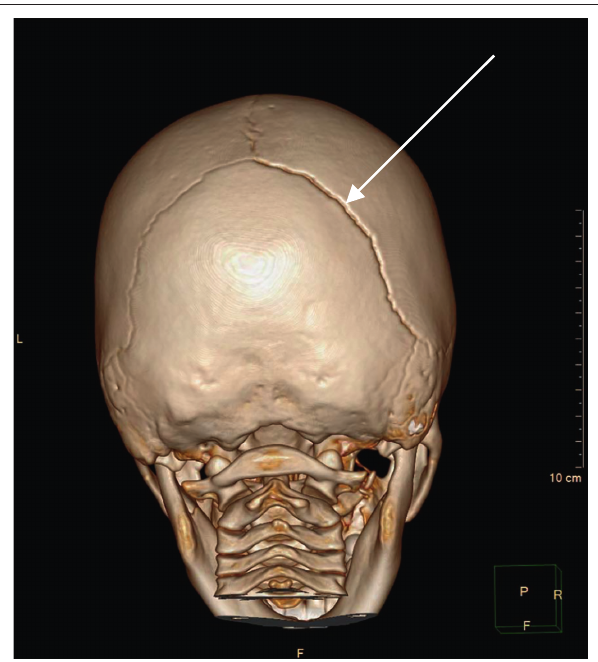
FIGURE 3: A 7 year old pedestrian was hit by a vehicle. 3D reconstruction demonstrated right lambdoid suture diastasis.